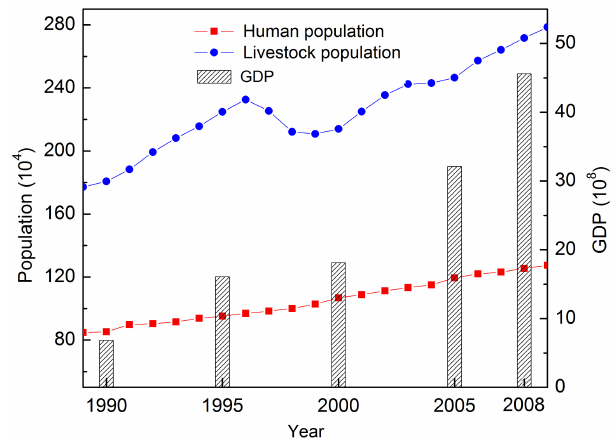
Figure 7. Population, livestock and GDP in the Hotan